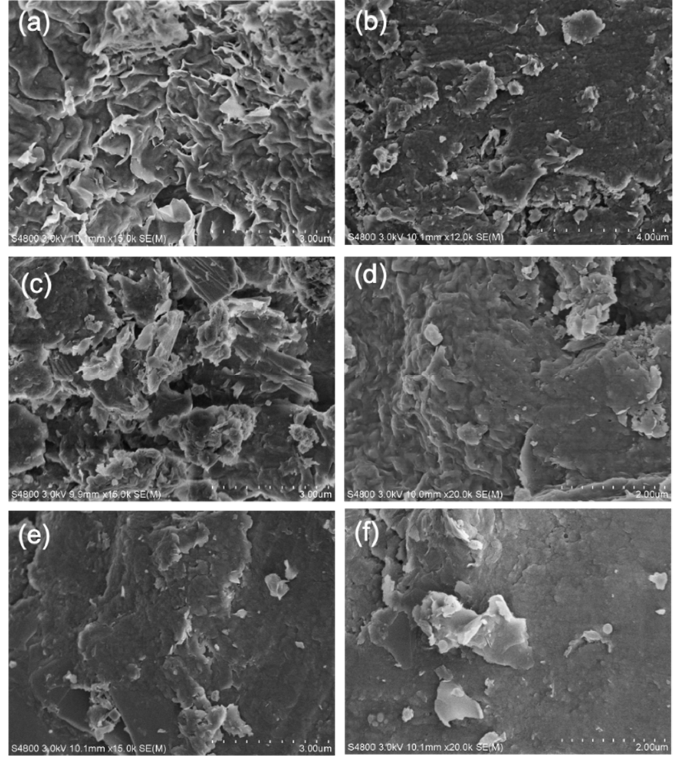
Figure 8. SEM images of bentonite ( a ), bentonite suspended in various concentrations of PADAD ( b ) 0.2%, ( c ) 0.5% ( d ) 1.0%, ( e , f )